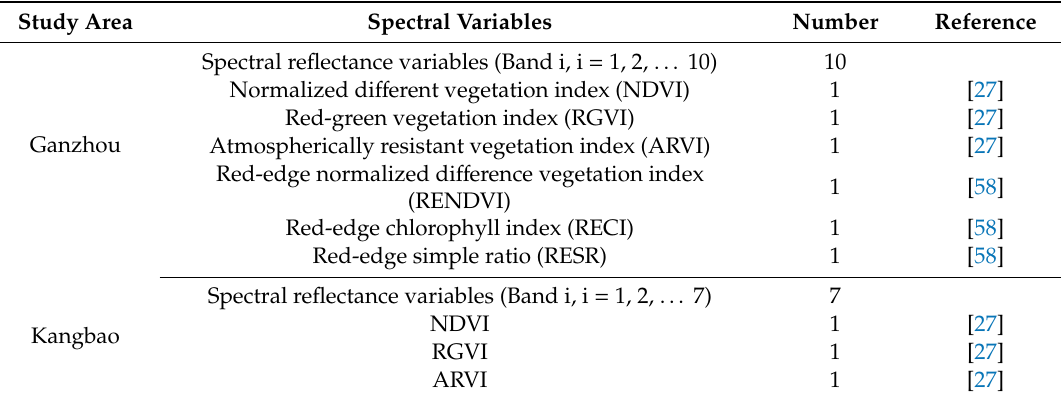
Table 2. The spectral variables used in this